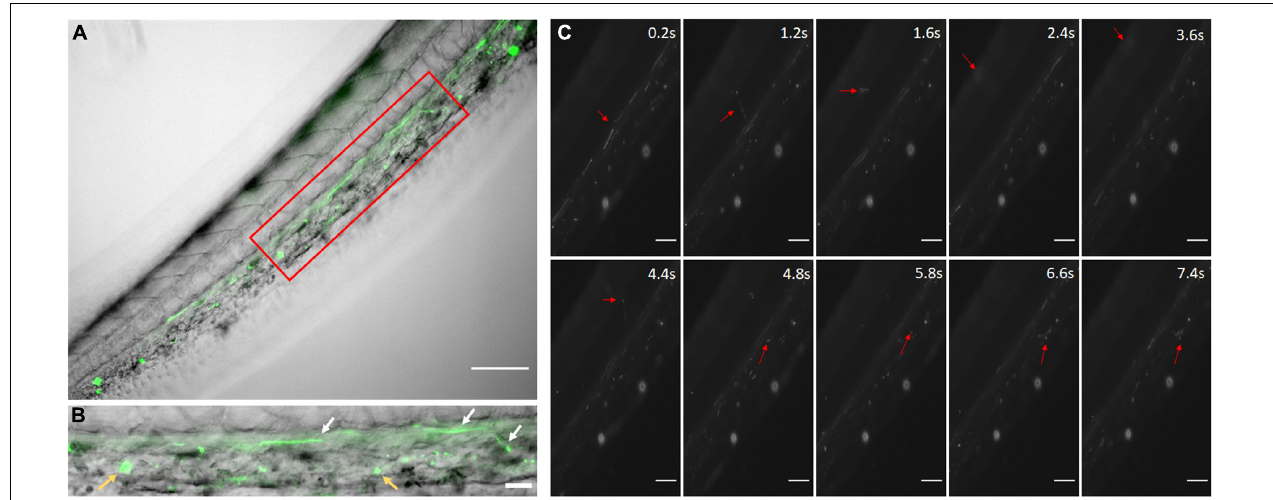
FIGURE 2 | Coumarin-6 Loaded Nanoparticles after Injection. (A) Coumarin-6 nanoparticles traveling in the caudal artery of the zebrafish tail. Red box is blown up and shown as (B) . White arrows show nanoparticles rolling along vessel walls. Yellow arrows indicate clusters of endocytosed nanoparticles. (C) Representative stills showing nanoparticles traveling from the caudal artery (0.2–1.2 s), into the capillaries of the tail tissue (1.6–4.8 s) and entering the posterior caudal vein (6.6–7.4 s). All scale bars represent 100 µ m.